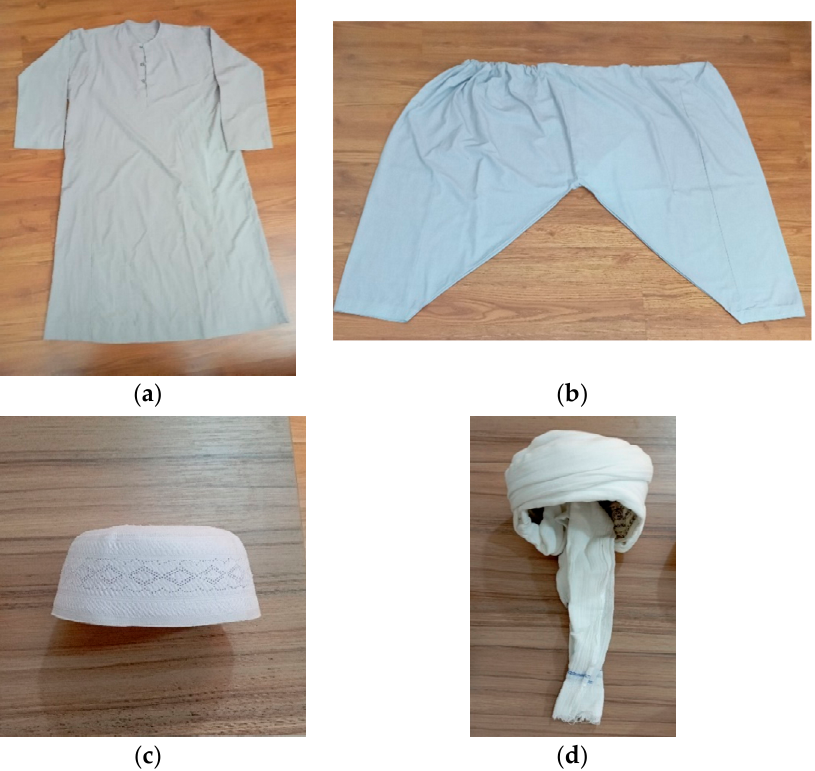
Figure 1. ( a ) Example of a kameez or jubba (source: author notes); ( b ) Example of a shalwar